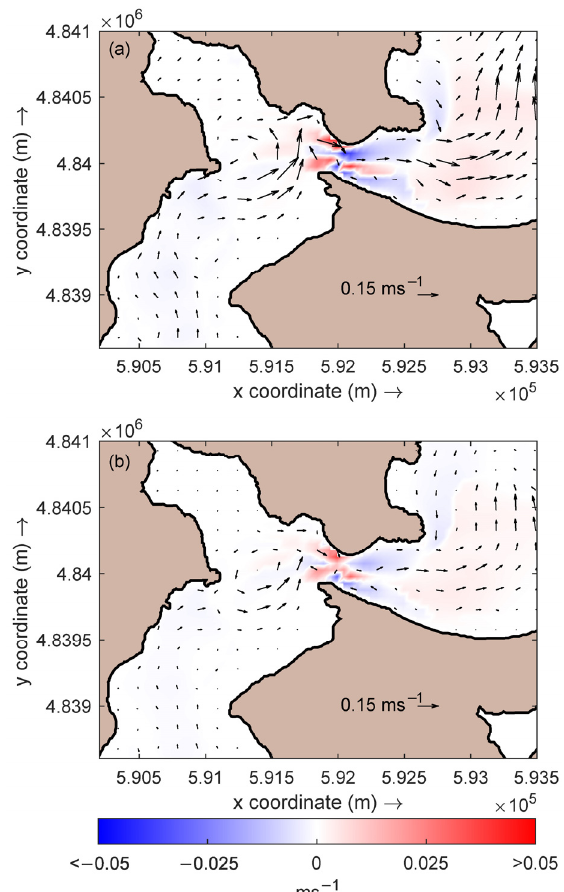
Figure 12. Residual flow pattern in Ria de Ortigueira under case study CS7 conditions (vectors); differences in the residual flow magnitude between altered flow and reference situation (CS7–CS4) (colour map). ( a ) Surface layer; ( b ) bottom layer.